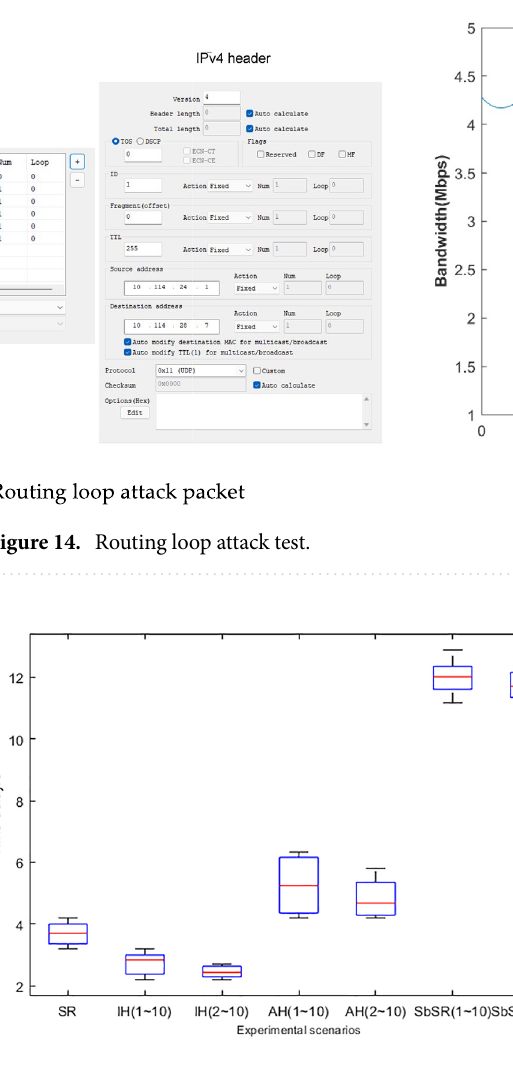
Figure 15. Comparison of time delay in different